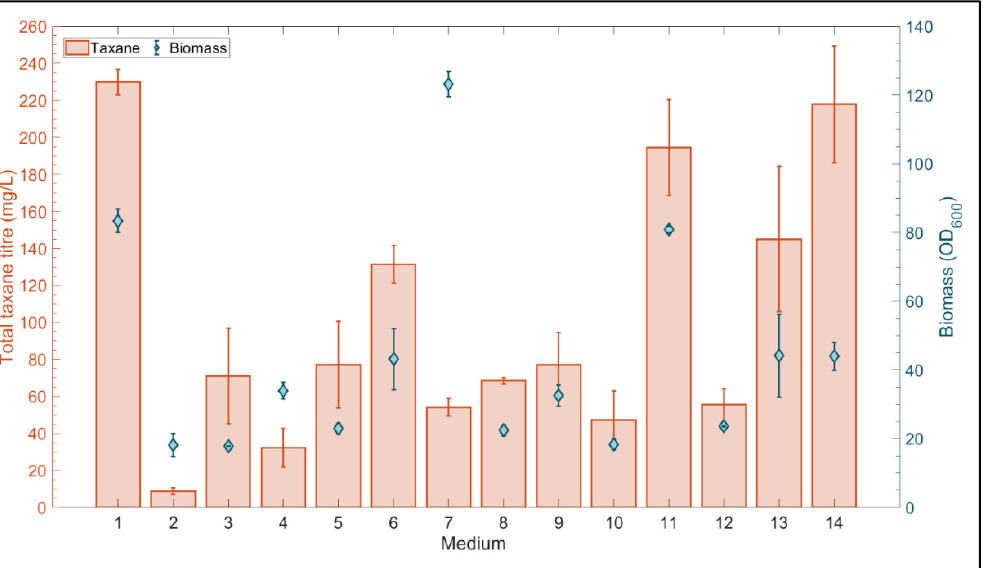
Figure 5. Microscale complex media screening results. Final total taxane and biomass titers obtained with each of the 14 media combinations in the BioLector. The values are mean ± standard deviation for triplicate cultivations.